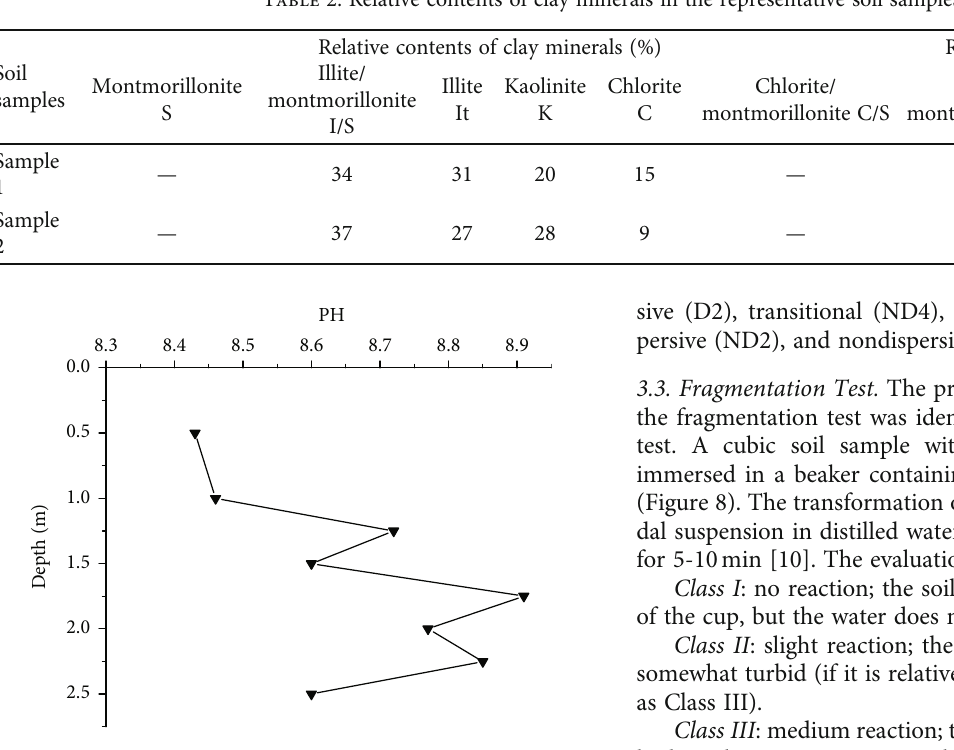
Figure 5: Relationship between pH and depth.